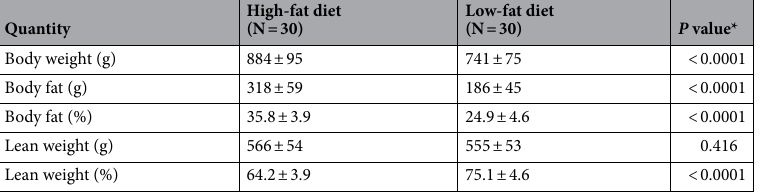
Table 3. Preoperative body composition, high-fat vs . low-fat diet. Values obtained after 6-month dietary induction phase, immediately prior to resection. Data = mean ± SD; *unpaired t-test.